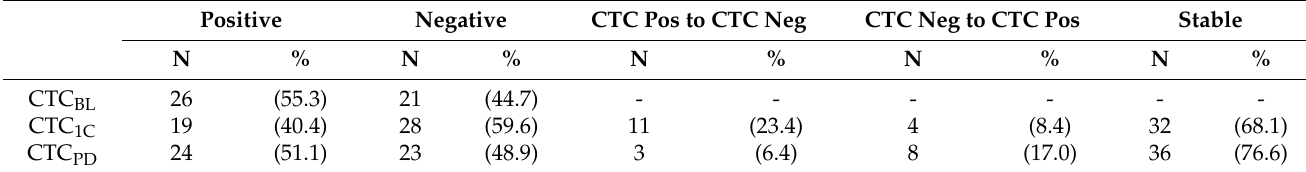
Table 2. CTC status and CTC status changes of patients across measurements in time.